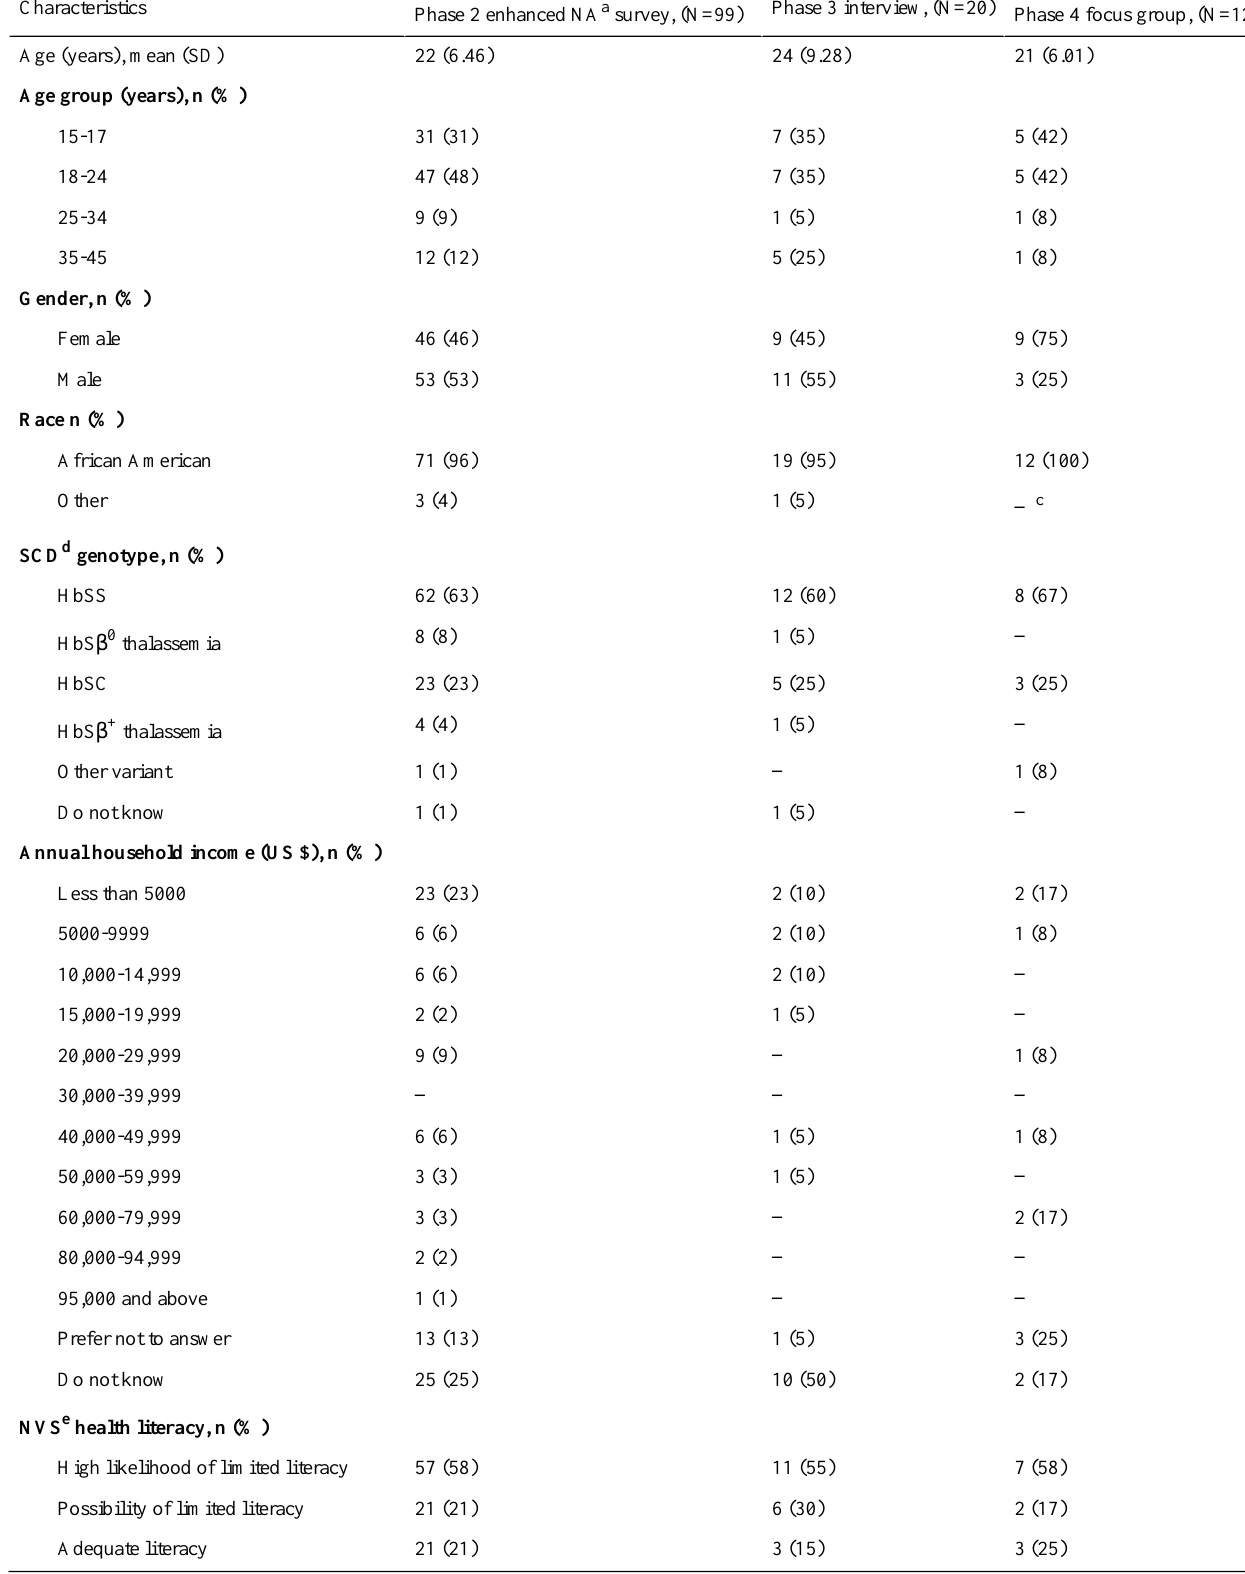
Table 1. Participant characteristics across phases 2, 3, and